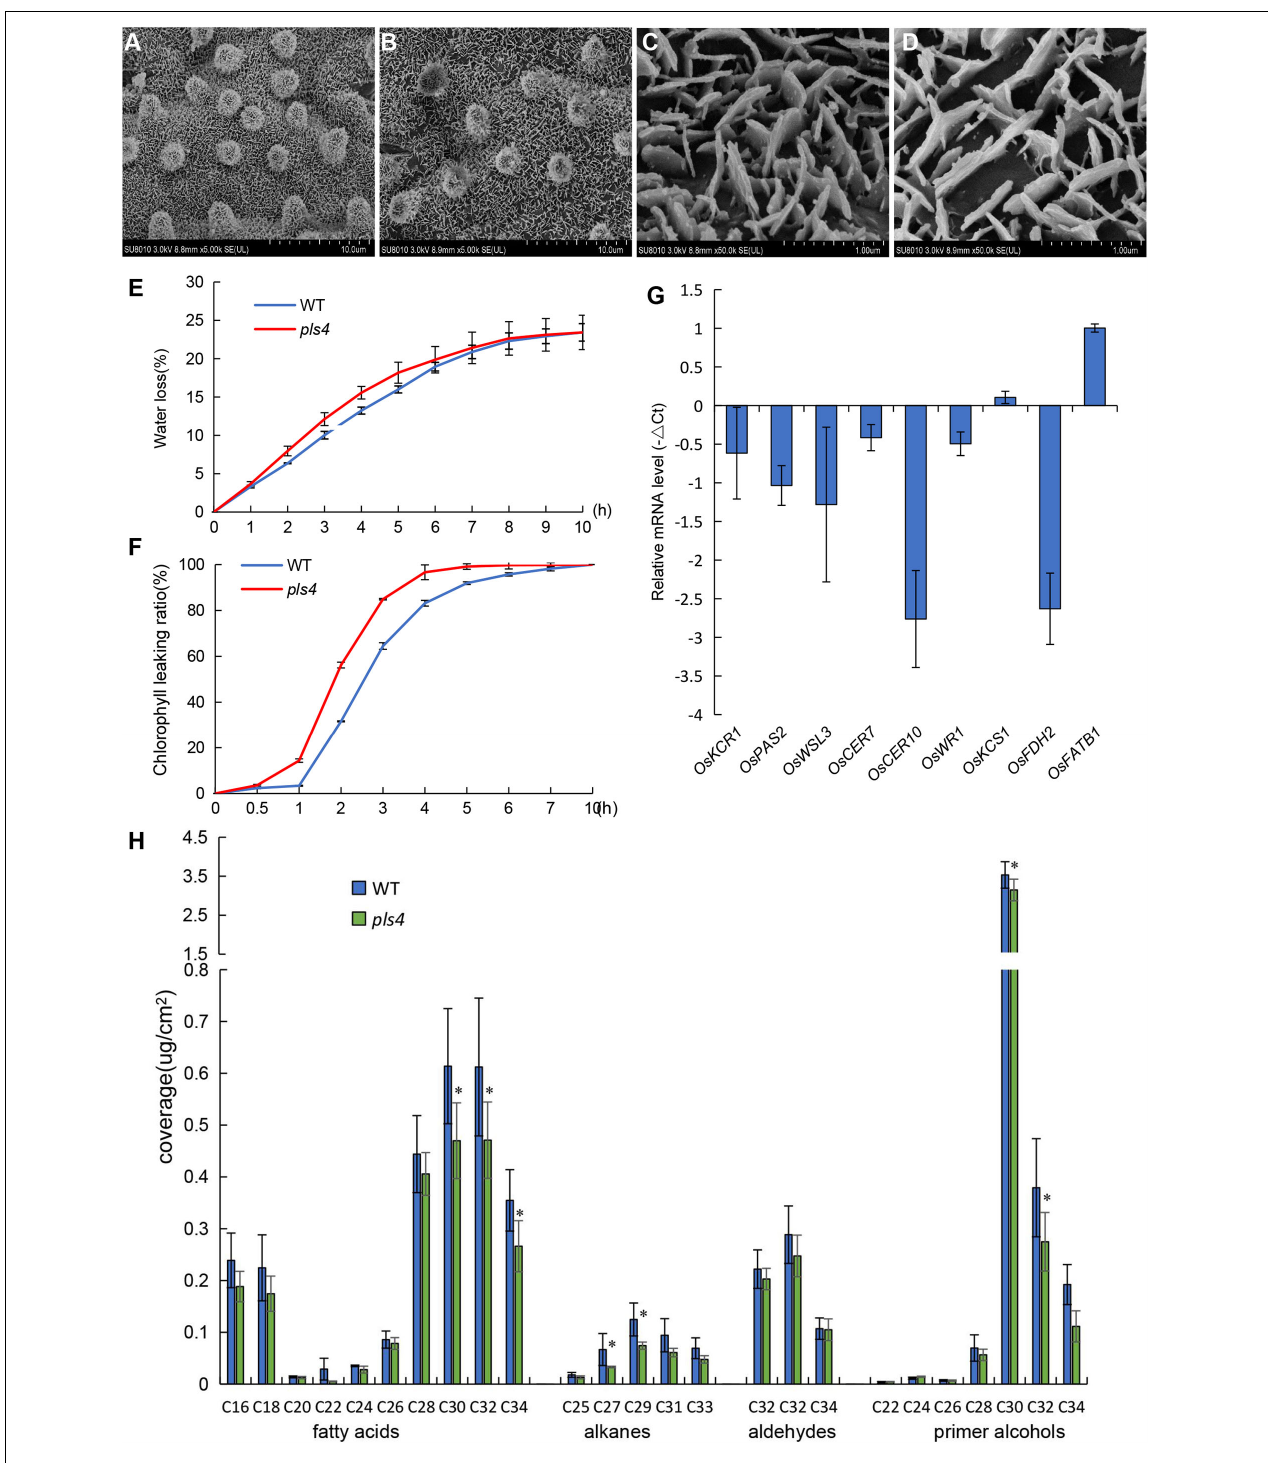
FIGURE 4 | Analysis of cuticular waxes in the leaves of the WT and pls4 mutant. (A–D) Cuticular wax crystals from the leaves of the WT (A,C) and pls4 mutant (B,D) at the heading stage by SEM. Bars = 50 µ m (A,B) , 5 µ m (C,D) . (E) Rate of water loss from detached leaves of the WT and pls4 mutant. (F) Chl leakage assays of leaves of the WT and pls4 mutant. (G) Relative expression of a set of genes associated with wax synthesis in the leaves of WT and pls4 mutant at the tillering stage. The data presented are the means ± SDs of three biological replicates. (H) Cuticular wax composition on the leaf surfaces of the WT and pls4 mutant analyzed by GC-MS. Asterisks denote significant differences from the WT. The data presented are the mean ± SD from five biological replicates. * P < 0.05 (Student’s t -test).